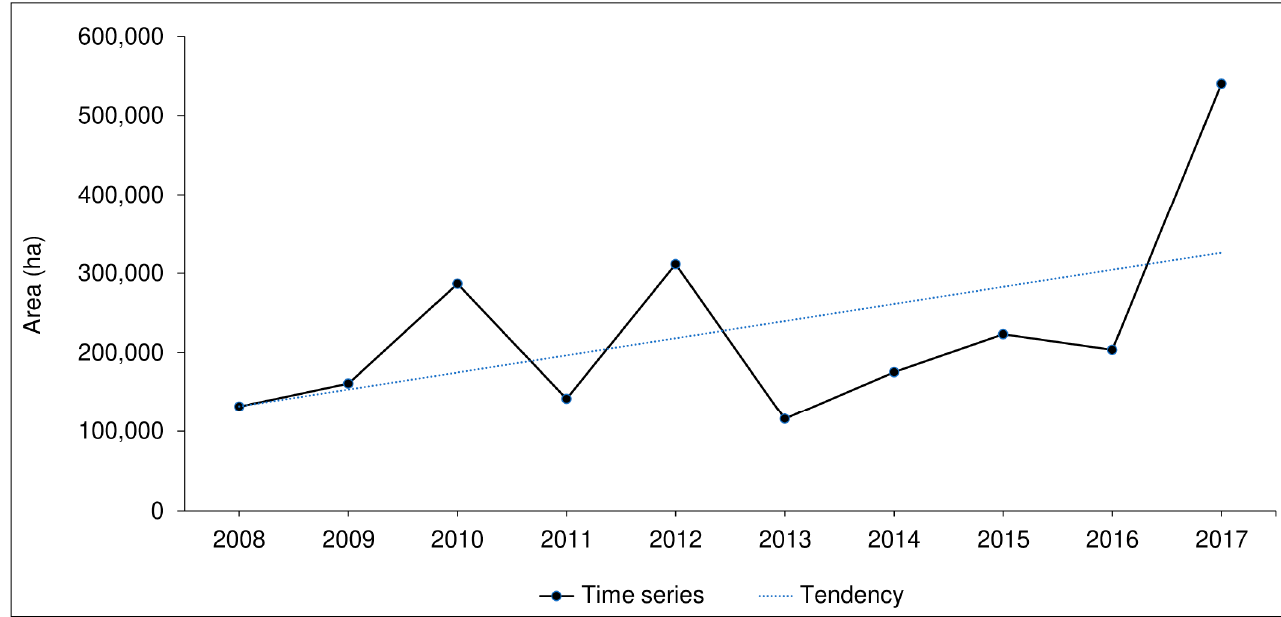
Figure 3. Yearly distribution of burned area from 2008 to 2017 and the linear tendency of increase.